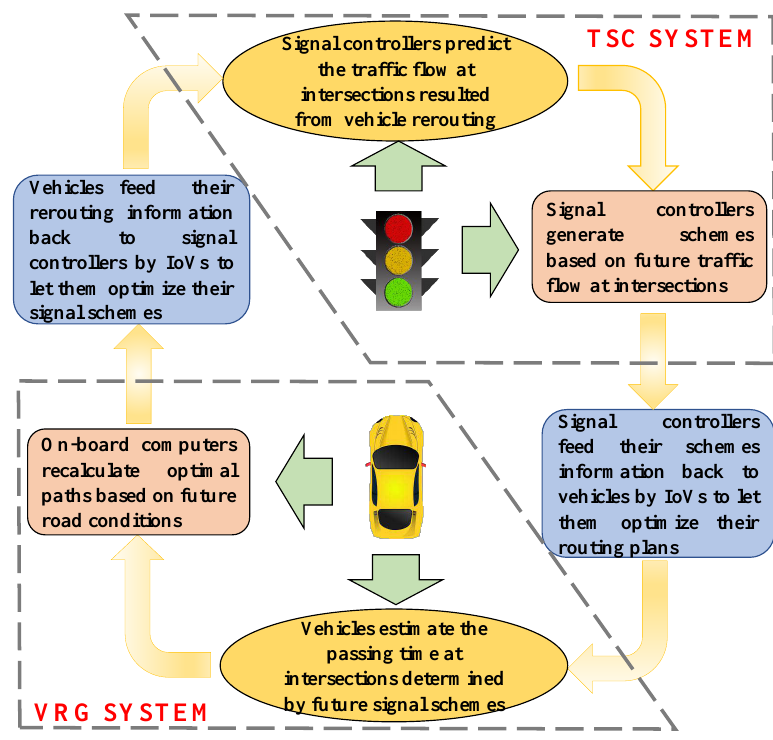
Figure 4. Feedback regulation between TSC and